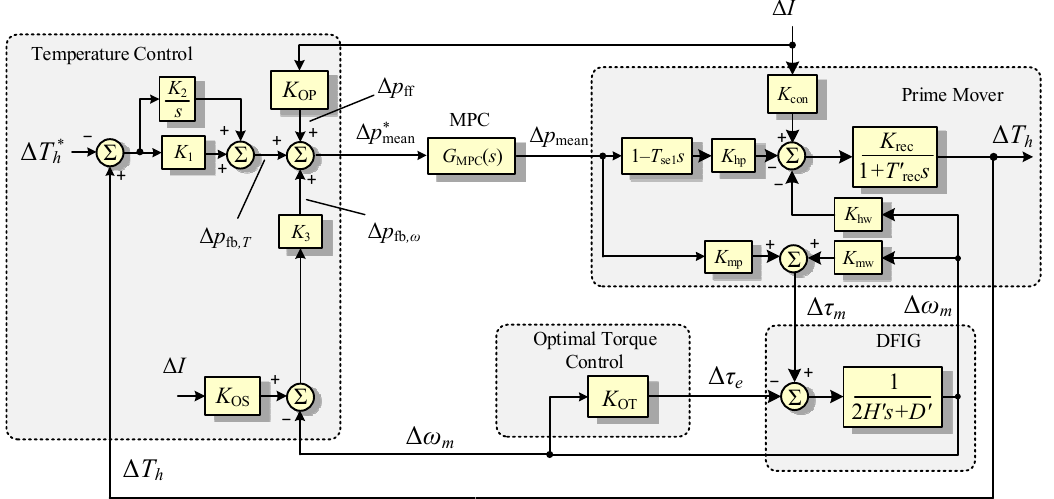
Figure 8. Block diagram of linearized TC-ROM for temperature controller design.